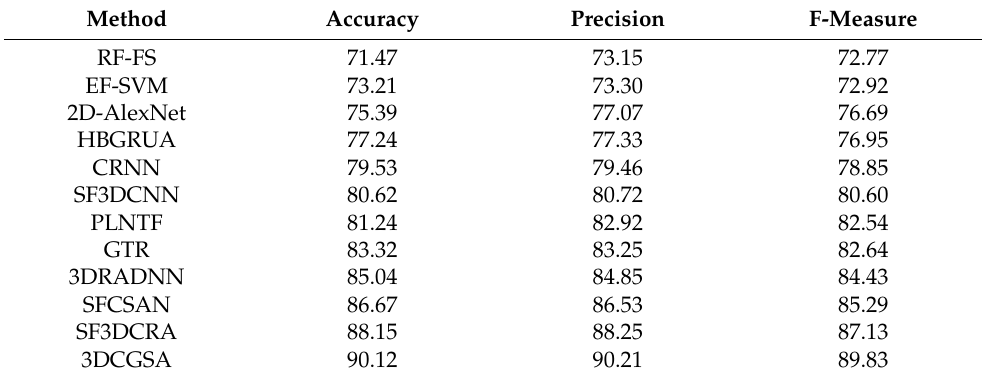
Table 4. Stress recognition results using the three-level EDESC dataset.